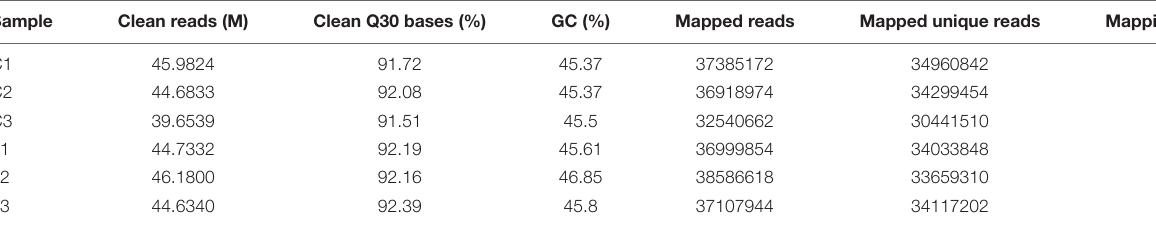
TABLE 4 | Main results of RNA-Seq.